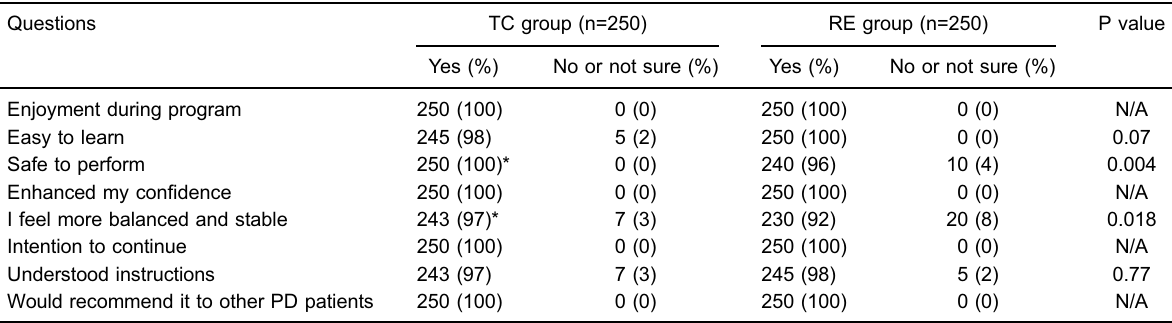
Table 2. Response of Parkinson ’ s disease (PD) patients who performed Tai Chi (TC) or routine exercise (RE) programs recorded in the fi nal